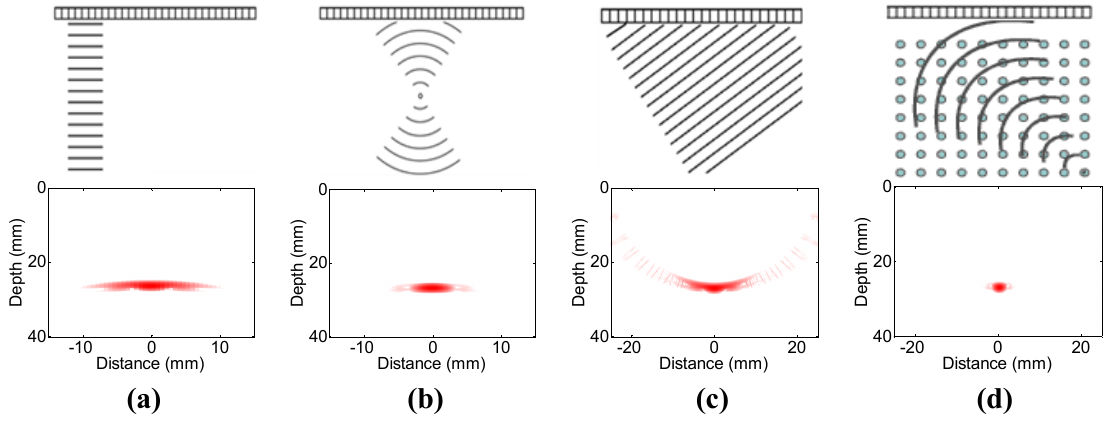
Figure 1. Schematic diagrams of conventional inspection methods, and images obtained for a single point reflector. (a) plane scan, (b) focused scan, (c) sector scan, (d) total focusing method. Point reflector is located on centre line of array and at a distance of 25 mm. Dynamic range is 40